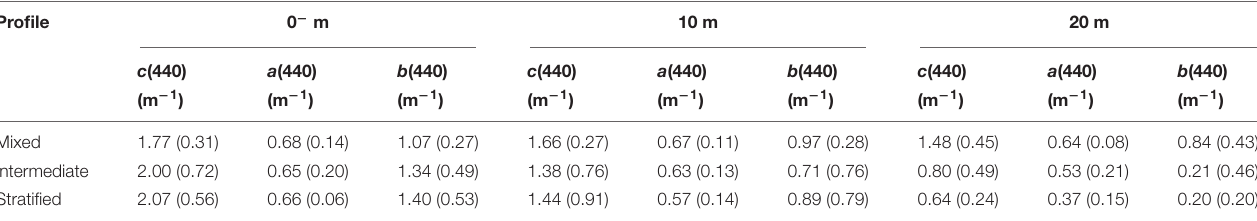
FIGURE 3 | Vertical profiles of temperature, salinity, attenuation coefficient ( c (440)), scattering coefficient ( b (440)), absorption coefficient ( a (440)) and b (440)/ a (440) at the wavelength of 440 nm during different hydrodynamic situations: (A) mixed water column down to a 25 m depth (the vertical temperature gradient was consistently < 0.1 ◦ C m − 1 ), (B) intermediate situation with steady vertical decrease in temperature (the vertical temperature gradient was steadily ≥ 0.1 ◦ C m − 1 ), (C) stratified profile (there was a layer with a vertical temperature gradient ≥ 0.1 ◦ C m − 1 under the layer where the gradients were steadily < 0.1 ◦ C m − 1 ). The dotted line on the b ( 440 )/ a ( 440 ) graph represents the boundary from which either the absorption b ( 440 )/ a ( 440 ) < 1 or scattering b ( 440 )/ a ( 440 ) > 1 dominates. In addition, the median concentrations of chlorophyll- a (Chl- a ) and total suspended matter (TSM) are given with the interquartile range. TABLE 2 | Inherent optical properties (IOPs) such as the attenuation coefficient ( c (440)), absorption coefficient ( a (440)), and scattering coefficient ( b (440)) at a wavelength of 440 nm for different hydrodynamic situations at different depths.